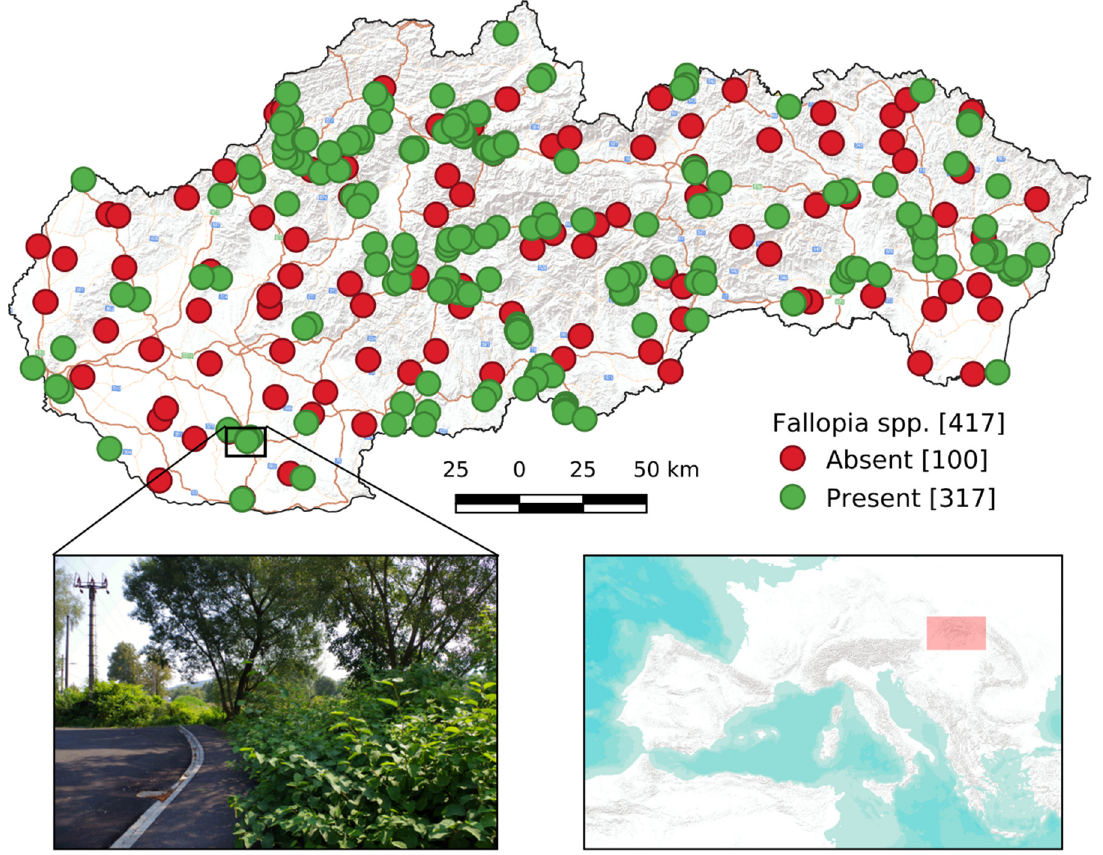
Figure 4. Fallopia taxa occurance data used in